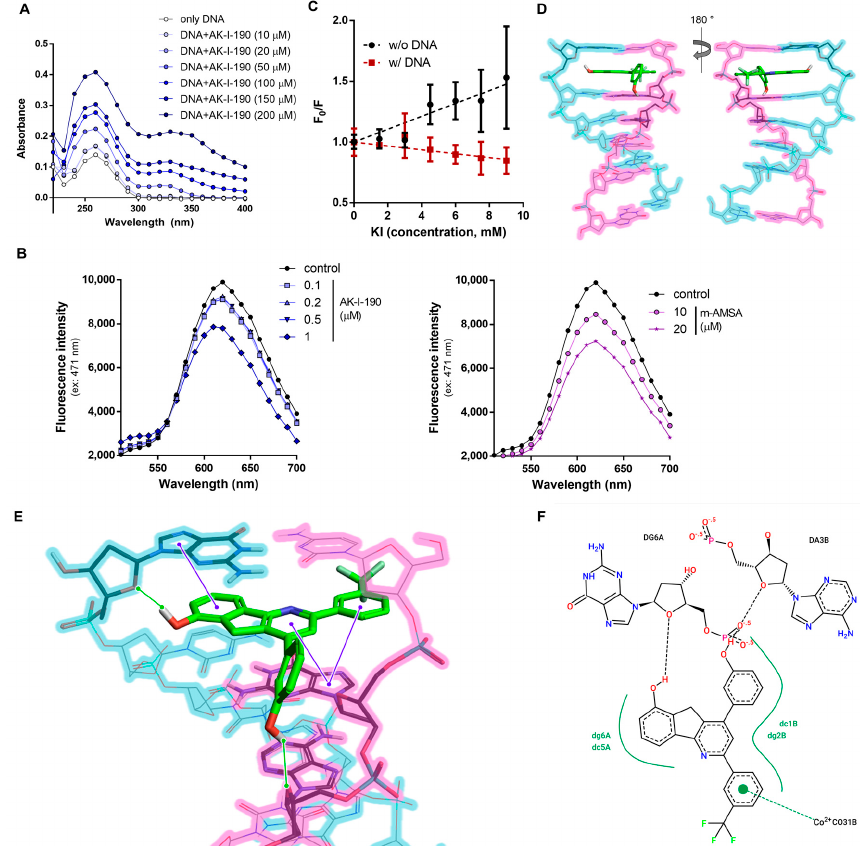
Figure 3. DNA intercalation of AK-I-190. ( A ) Interaction of AK-I-190 with ct-DNA was monitored using UV/vis spec- troscopy. UV/vis spectrum for ct-DNA (200 µ M) in the presence of various AK-I-190 concentrations (0–200 µ M) in 10 mM Tris buffer (pH 7.4). ( B ) Fluorescence spectra during titration of AK-I-190 to the complex of ct-DNA with EtBr (intercalator). The EtBr-DNA complex was excited at 471 nm and emission spectra were recorded from 500 nm to 700 nm. Fluorescence intensity decreased with subsequent addition of AK-I-190 (left) and m-AMSA (right). ( C ) KI quenching experiment. Stern– Volmer plot of fluorescence quenching of AK-I-190 (100 µ M) by increasing KI concentration (0–9 mM) in 10 mM Tris buffer (pH 7.4) in the presence (red) and absence (black) of ct-DNA. ( D , E ) Molecular docking study of AK-I-190. Docking studies of AK-I-190 were carried out using the X-ray crystal structure of human DNA complexed with ellipticine as a template (PDB code, 1Z3F) using the Flare program. AK-I-190 potentially binds to DNA double helix by intercalation between base pairs. Each DNA strand is shown as blue and pink highlighted lines. Residues participating in the interaction are indicated by bold sticks and AK-I-190 is shown by capped sticks. Both are colored according to atom (carbon, black or green; oxygen, red; nitrogen, blue; phosphorus, cyan; fluoride, light green). Expected hydrogen bonds are indicated as green solid lines and π – π interactions are represented as purple solid lines. ( F ) Two-dimensional diagram of the interaction between AK-I-190 and the DNA double helical structure. The diagram was created using Pose View in proteins.plus/ (accessed on 20 August